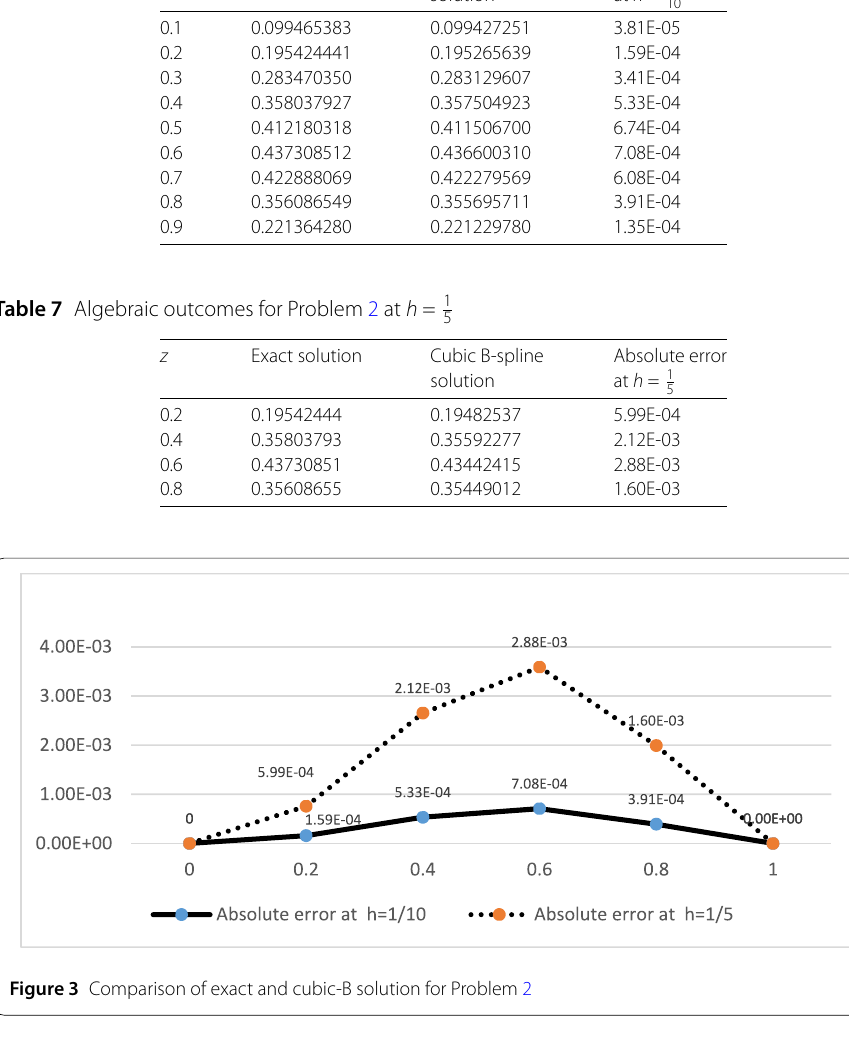
Table 6 Algebraic outcomes for Problem 2 at h = 1